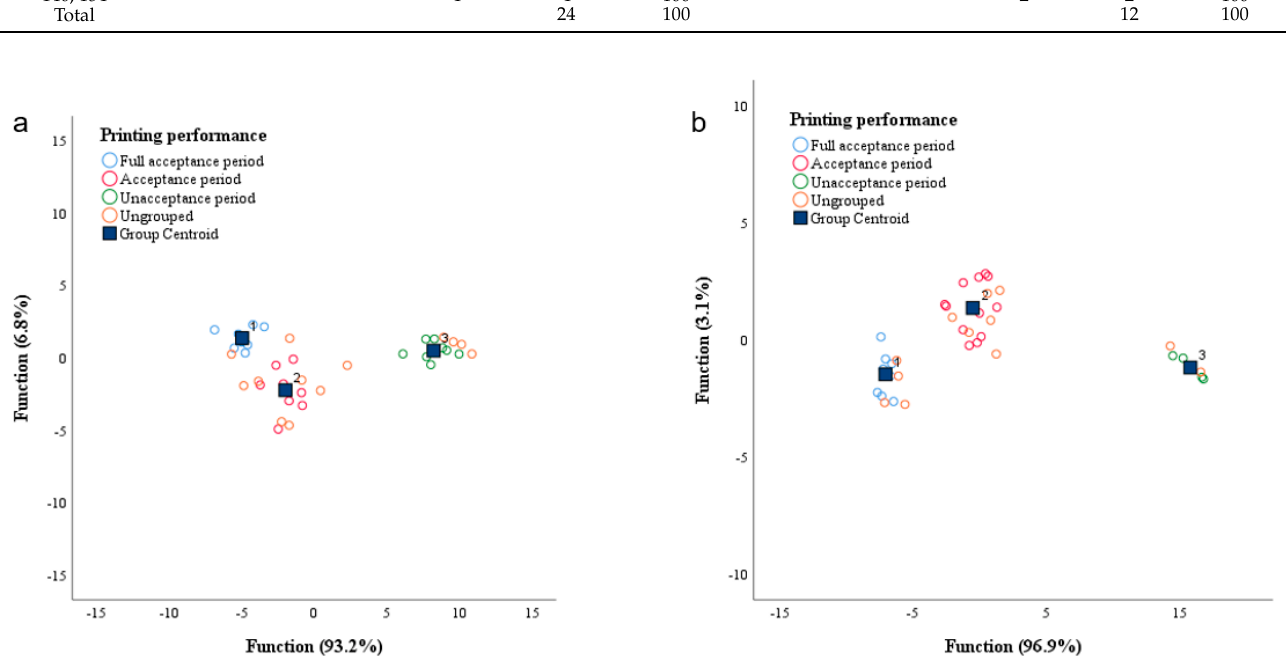
Figure 5. Fisher discriminant analysis plot of Sichuan sauerkraut during storage at different tem- peratures (the temperature of ( a ) is 45 °C; the temperature of ( b ) is 35 °C; 1: Full acceptance period; 2: Acceptance period; 3: Unacceptance period).